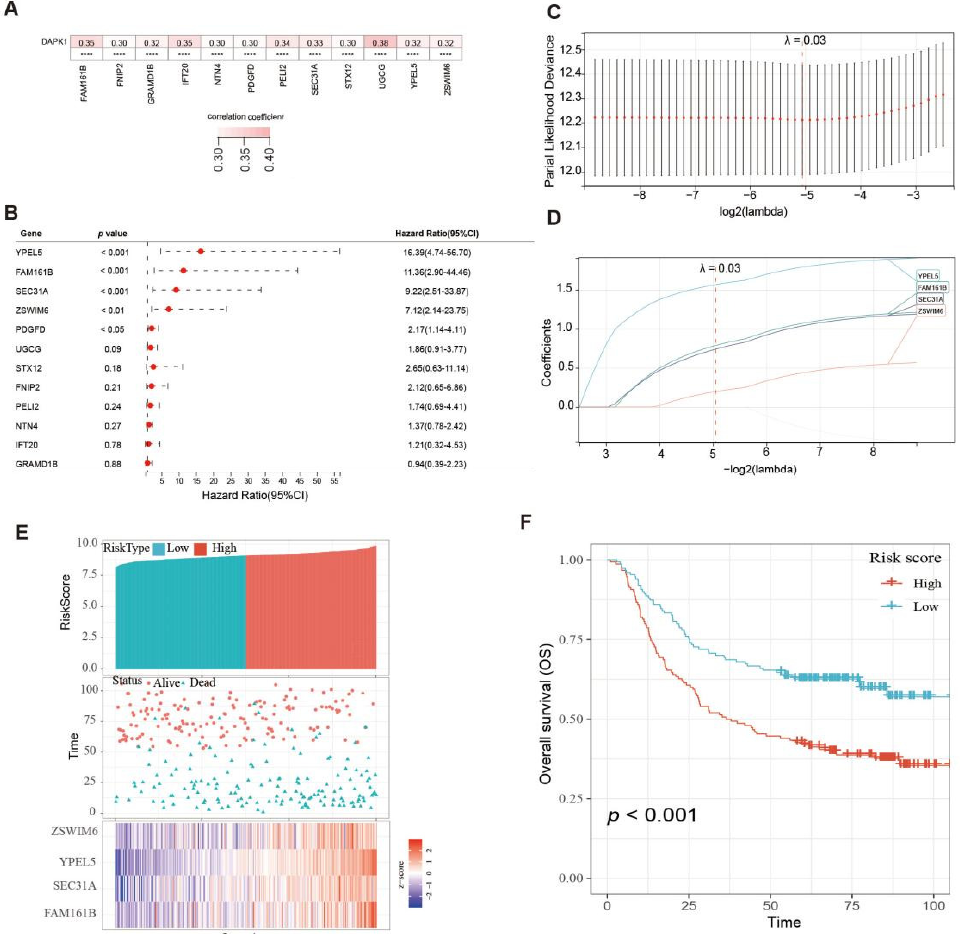
Figure 7. Construction of survival risk score system based on DAPK1-related genes. ( A ) The correlation between DAPK1 and DAPK1-related genes. ( B ) Survival analysis of the DAPK1-related genes. ( C ) Partial likelihood deviance of overall survival for LASSO coefficient profiles. ( D ) LASSO coefficient profiles of 4 genes for overall survival. ( E ) The distribution of survival status, risk scores, and the expression of four genes of GC patients. ( F ) Survival analysis of risk score module.